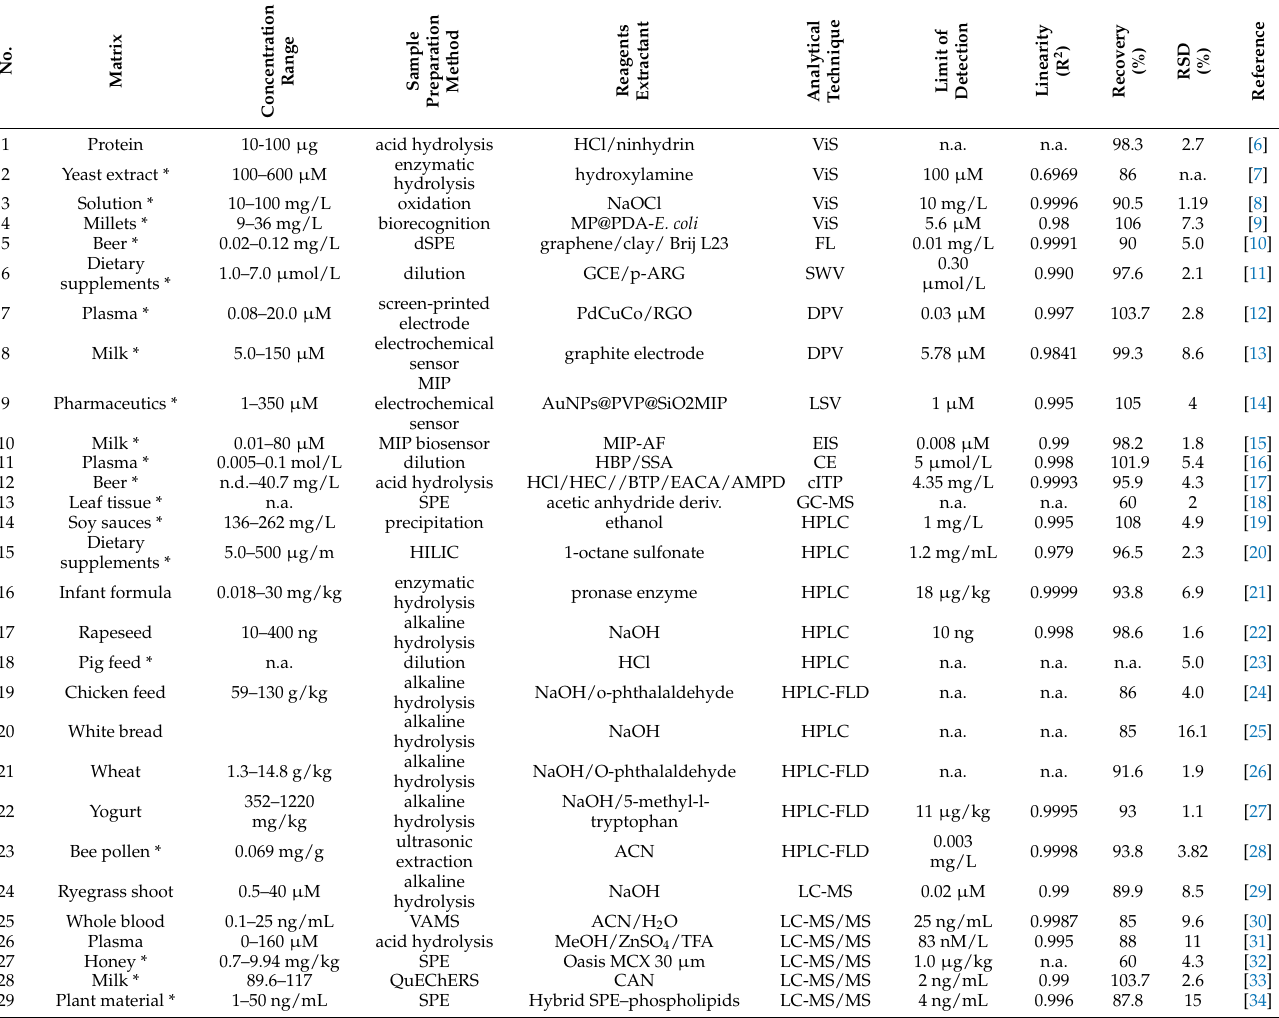
Table 3. Comparison of the proposed method with other reported methods for the determination of tryptophan.